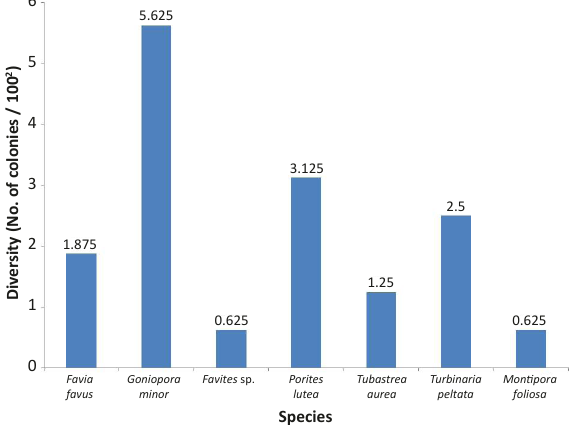
Figure 1. Density of coral colonies/100m 2 of coral species in Kuchdi- Porbandar area